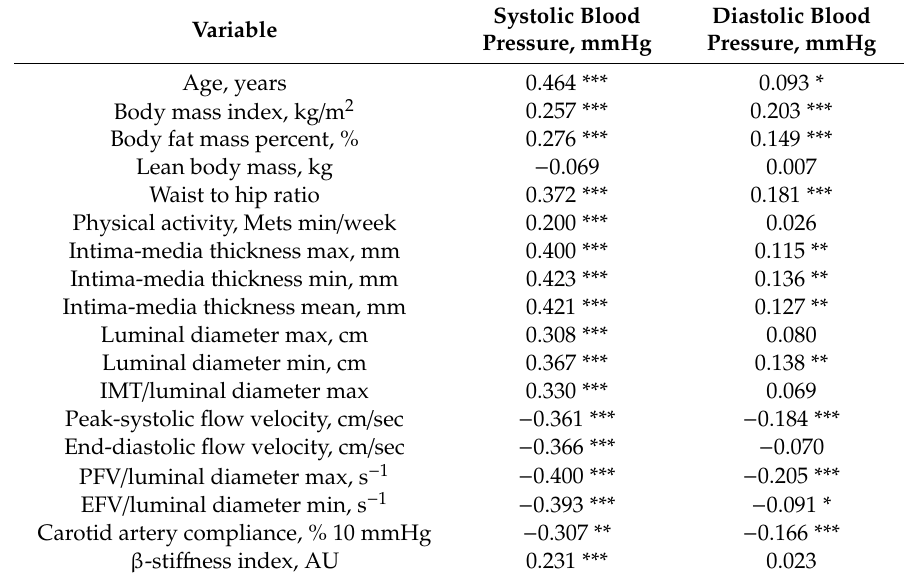
Table2. CoefficientofPearson’scorrelationsbetweenbodycompositionandcarotidarterialcharacteristics with blood